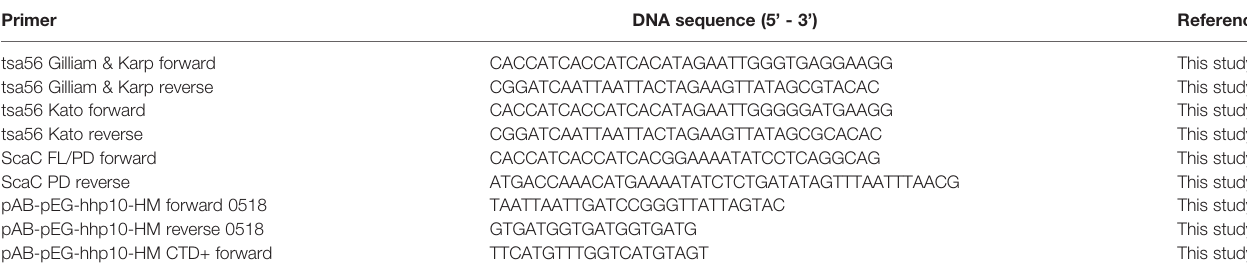
TABLE 1 | Primers used in this study.